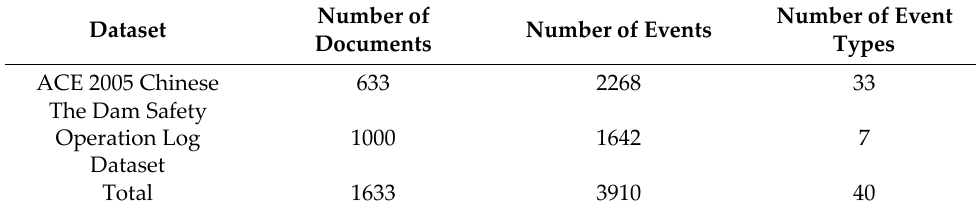
Table 3. Comparison of two datasets.